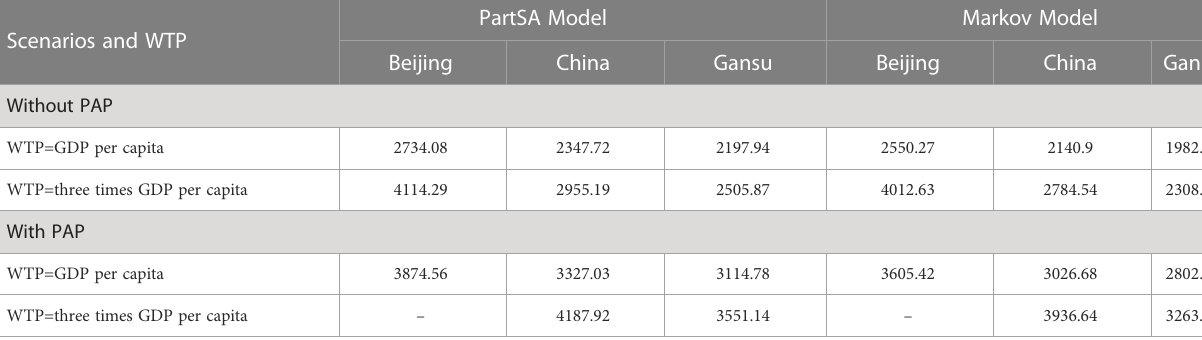
TABLE 4 Cost-effective price of atezolizumab in different regions.